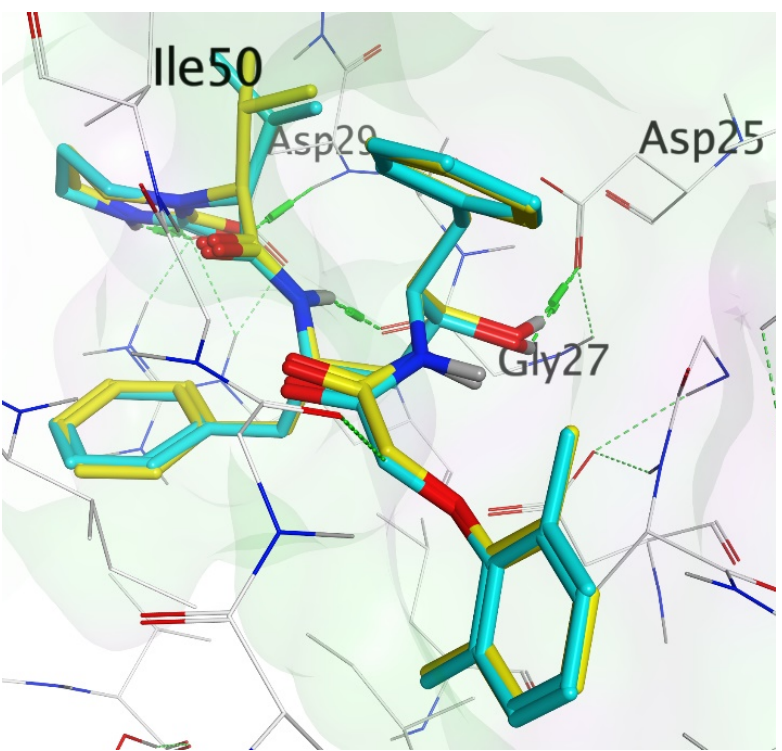
Int. J. Mol. Sci. 2022 , 23 , x FOR PEER REVIEW Figure 3. Validation of the docking protocol with HIV-1 protease bound to lopinavir. The docked lopinavir (green) was overlaid on the co-crystallized lopinavir (yellow).